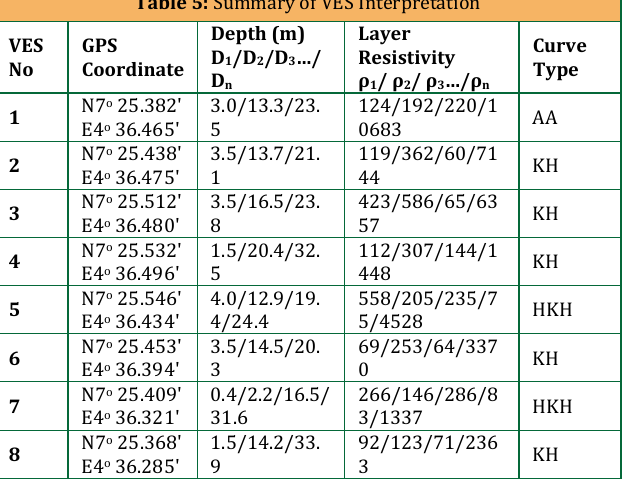
Table 5: Summary of VES